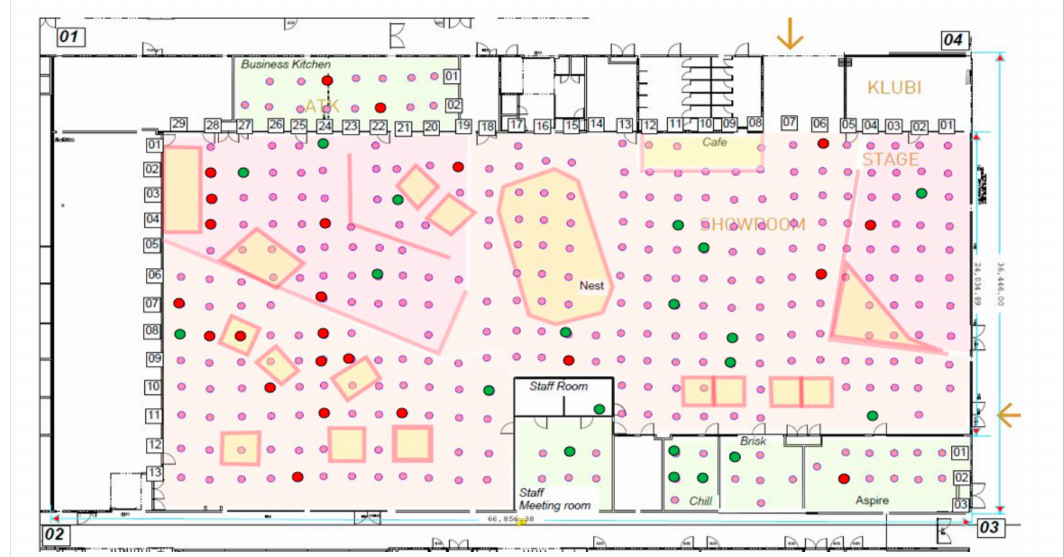
Figure 3. The floor plan showing the sensor node deployment in Tellus area inside the University of Oulu. The deployed sensors are shown as dots, distances are shown in meters, green dots indicate the sensors with the lowest packet error rate (PER) and the red dots are the ones with highest PER. Further details are provided in Section